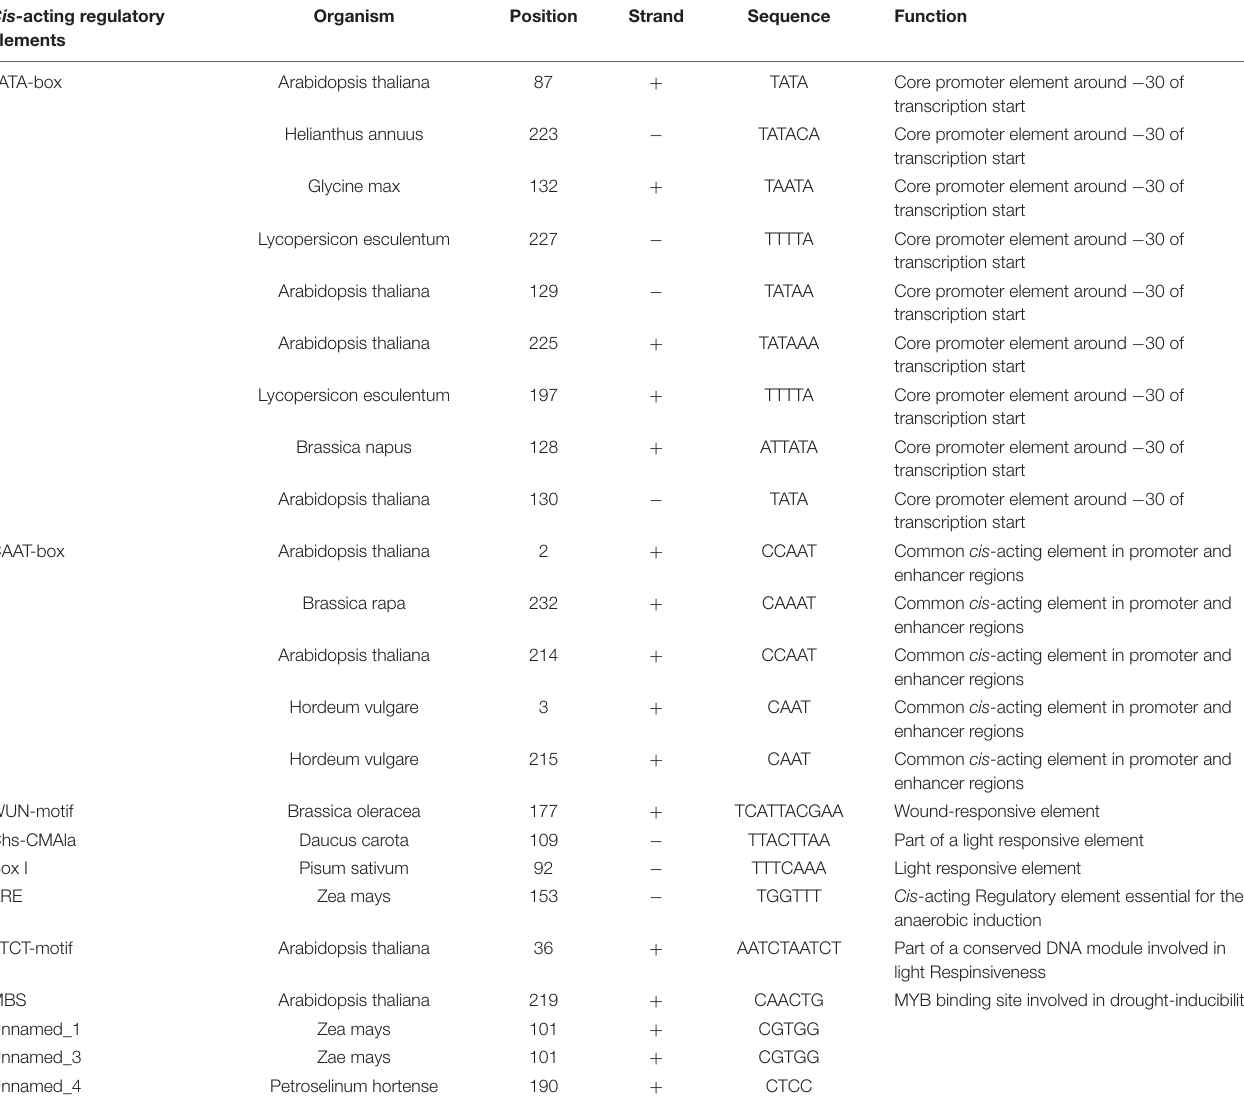
TABLE 2 | Sequence analysis of WY195 promoter using